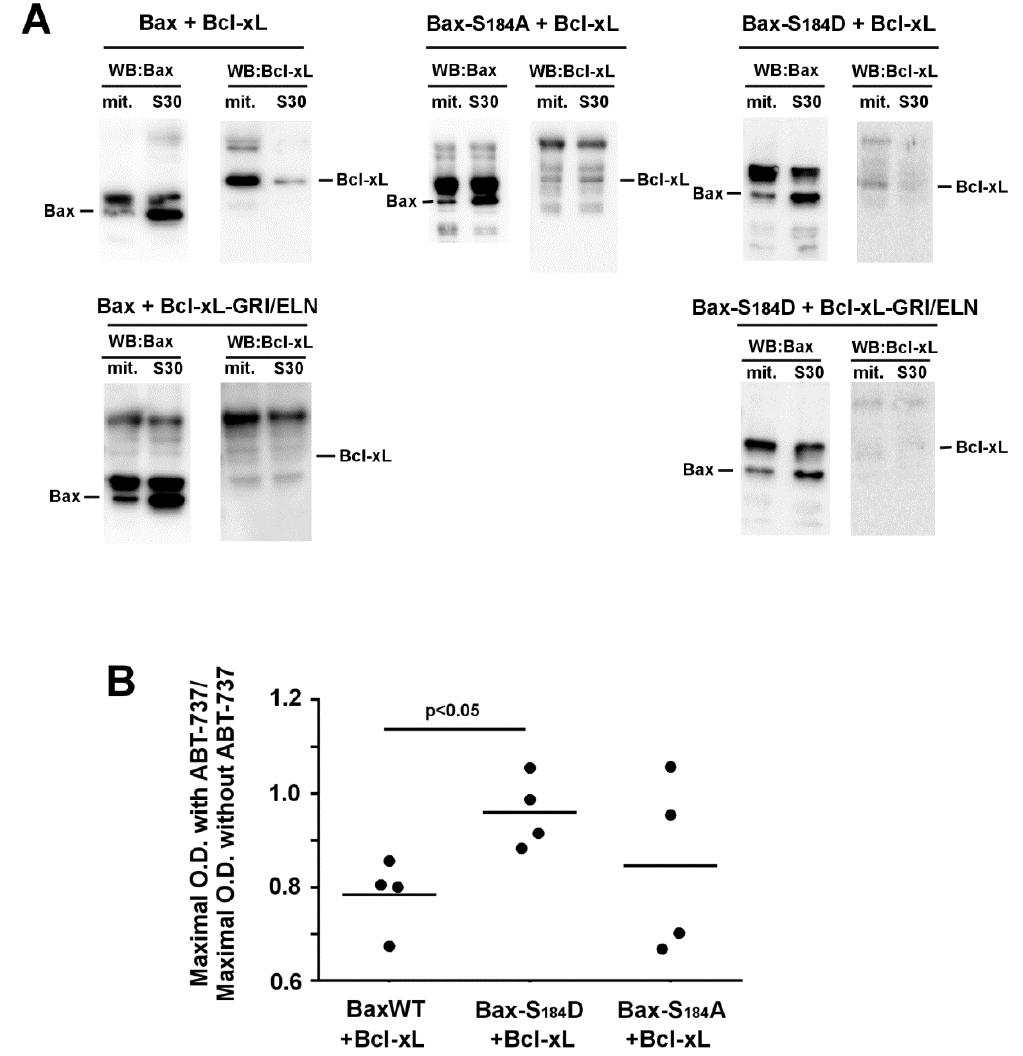
FIGURE 4: Interaction between Bax and Bcl-xL. (A) Immunoprecipitation experiments were done on mitochondria and S30 fractions from cells expressing indicated Bax mutants with or without Bcl-xL or Bcl-xL GRI/ELN, as a negative control. 2 mg proteins of each fraction were immunoprecipitated with an anti-Bax antibody (2D2, Sigma). Blots are representative of experiments that have been done 5 times for Bax/Bcl-xL, 3 times for Bax-S184A/Bcl-xL and Bax-S184D/Bcl-xL, and twice for negative controls with Bcl-xL-GRI/ELN. Inputs were omitted for clarity and can be seen in Fig. S1. (Left) (Top) The IP against Bax showed the interaction with Bcl-xL only in the mitochondrial fraction. (Left) (Bottom) and (Right) (Bottom) The absence of signal when BaxWT or Bax-S184D were co-expressed with Bcl-xL GRI/ELN evidenced the speci- ficity of the signal. (Middle) Bax-S184A was co-expressed with wild-type Bcl-xL. The interaction was very weak, and similar in both fractions. (Right) Bax-S184D was co-expressed with wild-type Bcl-xL. Like for BaxWT, the interaction with Bcl-xL occurred mostly in the